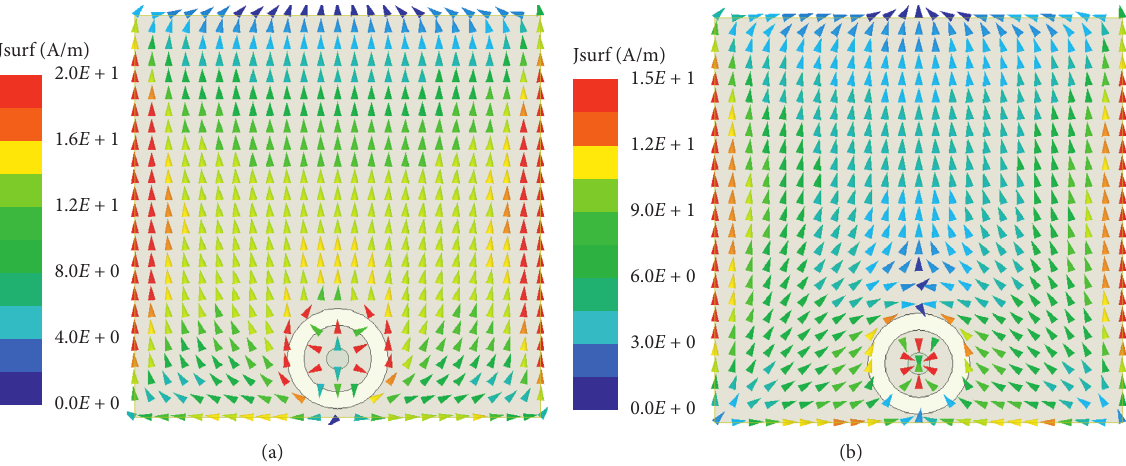
Figure 4: Current distributions on the radiation square patch of Design 1: (a) f